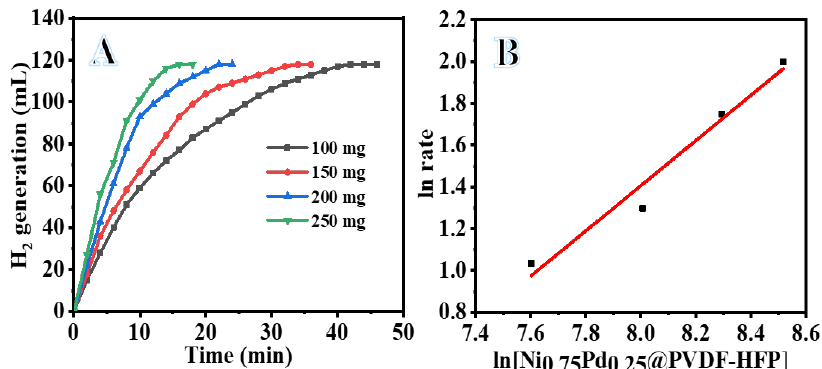
Figure 7. Effect of Ni 75 Pd 25 @PVDF-HFP NFs membrane amount on H 2 production by SBH hydrolysis ( A ), and H 2 generation rate vs. amount of catalyst on the logarithmic scale ( B ). [SBH] = 1 mmol and T = 303 K. Table 2. Effect of Ni 75 Pd 25 @PVDF-HFP amount on the hydrolysis of NaBH 4 .